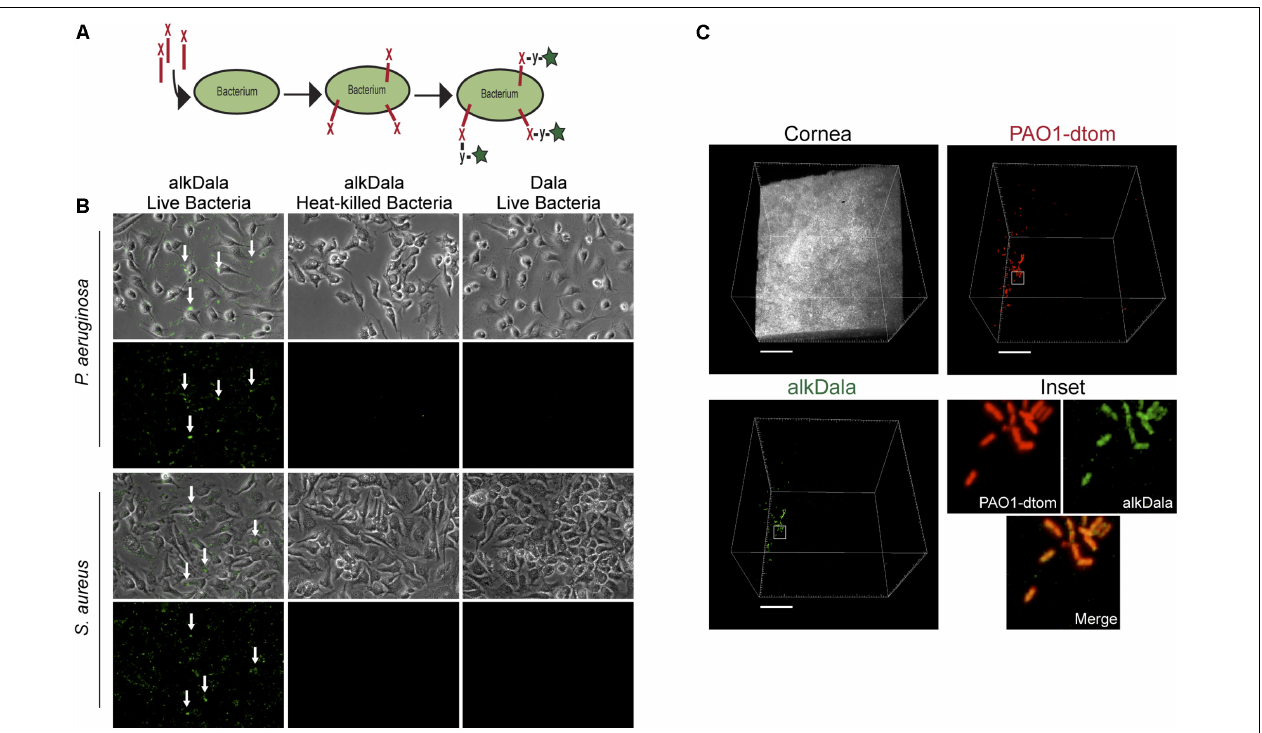
FIGURE 1 | Alkyne-functionalized D -alanine (AlkDala) detects metabolically active bacteria inoculated onto cell culture and the murine cornea. (A) Schematic of alkDala (shown as a red X) labeling of bacteria. AlkDala is added to a bacterial suspension to allow incorporation into the cell wall peptidoglycan followed by a copper-catalyzed click-chemistry reaction with an azide-fluorophore (shown as a y-star symbol) to detect bacteria with incorporated probe. (B) AlkDala labeling was tested on Pseudomonas aeruginosa (PAO1) and Staphylococcus aureus (clinical isolate) in the presence of HeLa cells, and labeled all live bacteria (green, arrows) (Lower Left) . Heat-killed bacteria were not detected (Lower Middle) , nor were live bacteria detected if incubated with D -alanine without an attached alkyne (Lower Right) . (Upper) show the phase-contrast images of respective fields. (C) To determine if bacteria on the murine ocular surface could be labeled with alkDala, whole eyeballs were incubated in ∼ 10 11 CFU/mL of red fluorescent P. aeruginosa (PAO1-dtom) for 5 h, and then labeled using alkDala (green). The same fields of view are shown with different emission filters. Inset shows zoom of the white box with merge. Scale bar, 50 µ